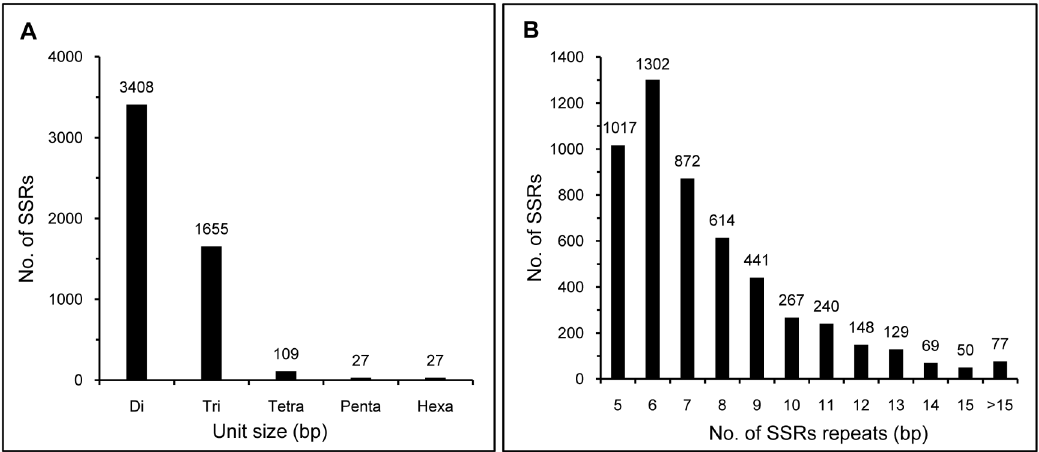
Figure 5. Frequency distribution of the SSRs identified in transcriptome dataset. (A) Distribution of the total number of EST-SSRs in different classes of repeat type. Di-, tri-, tetra-, penta- and hexa-nucleotide repeats were analyzed. (B) Distribution of the number of SSRs repeats. The number of repeats ranged from 5 to 39.